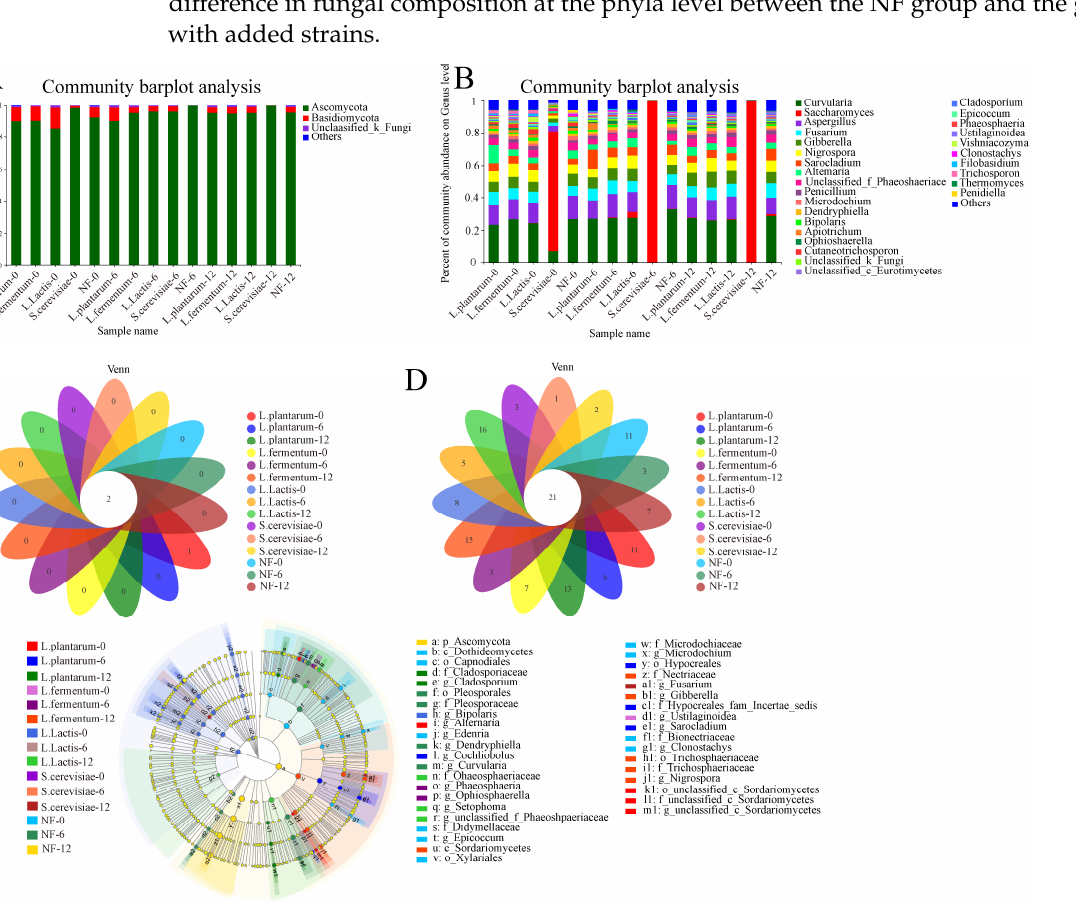
Figure 3. Changes of fresh fermented rice noodles fungal diversity. ( A ) Relative abundance of fungal community at the phyla level; ( B ) Relative abundance of fungal community at the genus level. ( C ) The Veen diagram of fungal composition the phyla level; ( D ) The Veen diagram of fungal composition the genus level; ( E ) Linear discriminant analysis effect size (LEfSe) analysis of the fungal composition. L. plantarum represents adding Lactobacillus plantarum ; L. fermentum represents adding Lactobacillus fermentum ; L. lactis represents adding Lactococcus lactis ; S. cerevisiae represents adding Saccharomyces cerevisiae and NF represents fermented naturally .